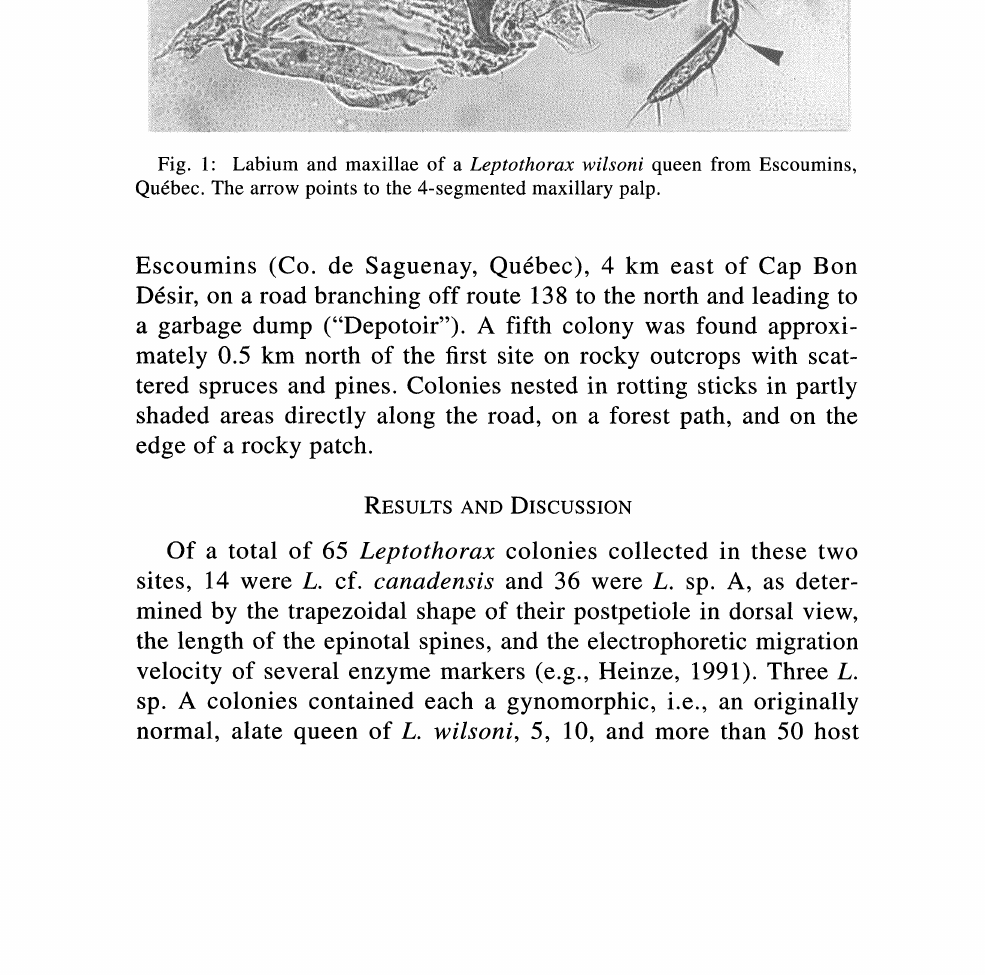
Fig. 1: Labium and maxillae of a Leptothorax wilsoni queen from Escoumins, Qu6bec. The arrow points to the 4-segmented maxillary palp.